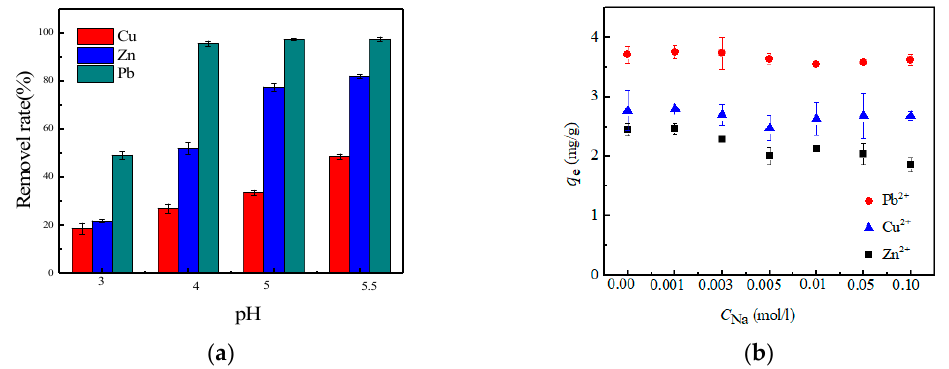
Figure 4. Effect of pH ( a ) and ionic strength ( b ) on removal of Pb 2+ , Cu 2+ , or Zn 2+ by PPG-nZVI beads. Figure 4. E ff ect of pH ( a ) and ionic strength ( b ) on removal of Pb 2 + , Cu 2 + , or Zn 2 + by PPG-nZVI